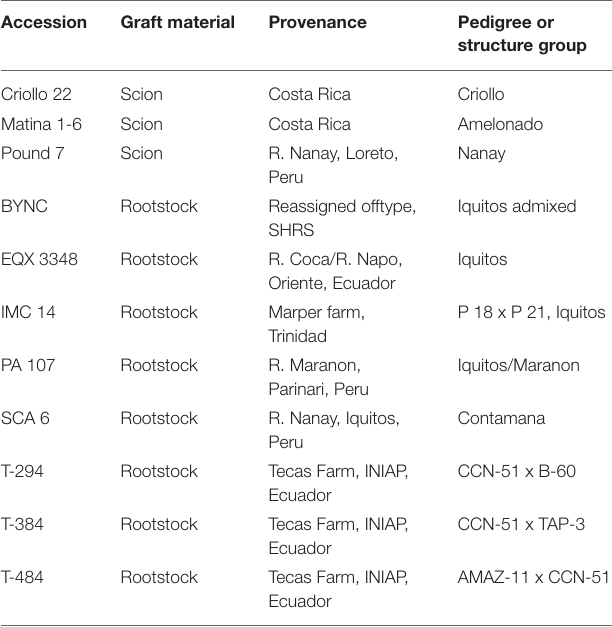
TABLE 1 | Cacao germplasm used in the